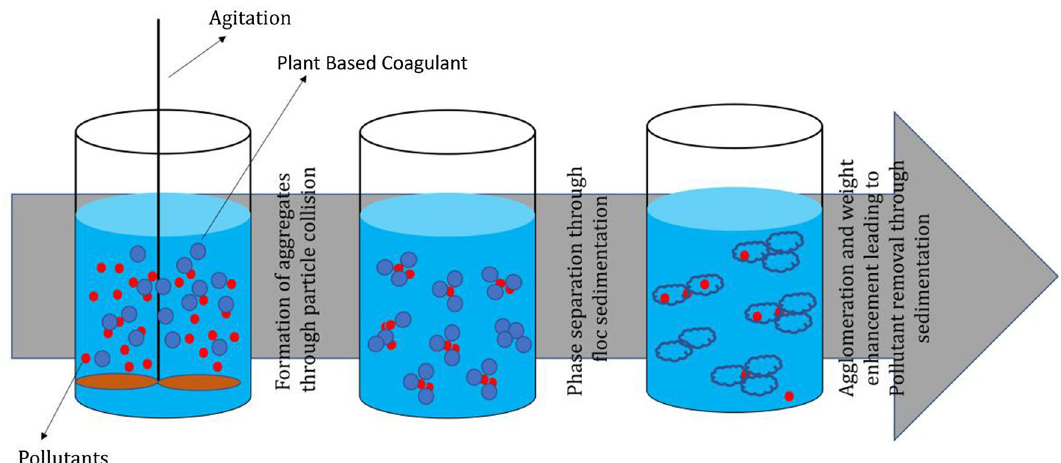
Fig. 26 Illustrative representation of the coagulation